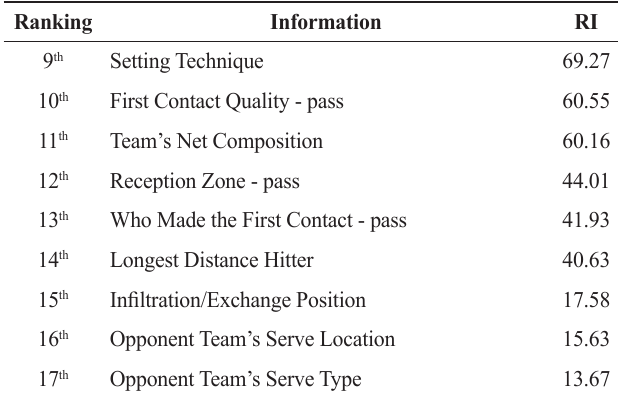
Table 2: Classification of information contained in the Attack Pro- cesses based on their Response